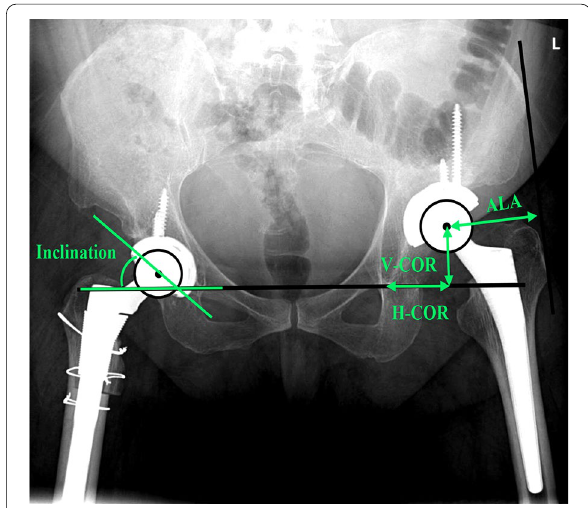
Fig. 1 Diagram for postoperative radiographic measurement. V-COR: vertical center of rotation; H-COR: horizontal center of rotation; ALA: abductor lever arm